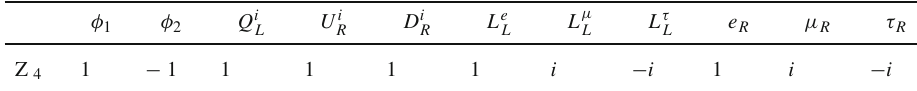
Table 1 The Z 4 charge assignment of μ – τ